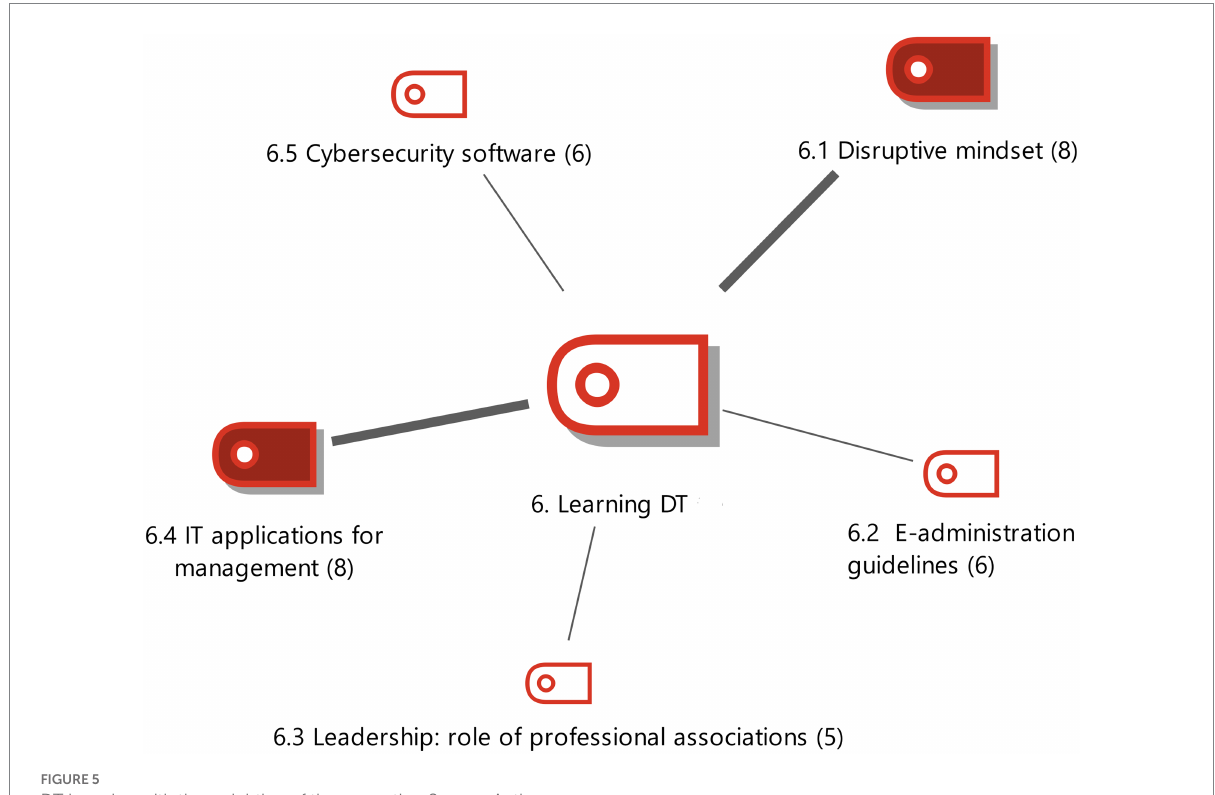
FIGURE 5 DT Learning with the weighting of the properties. Source: Authors